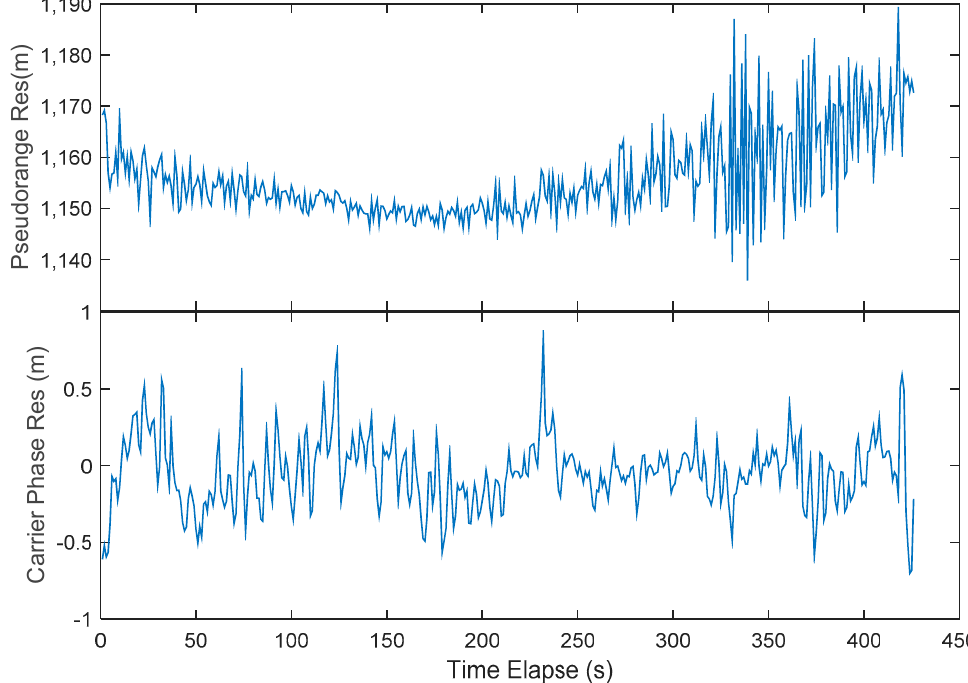
Figure 12. Representative pseudorange and carrier phase measurement residuals of the Luojia-1A with error sources corrected by empirical models.